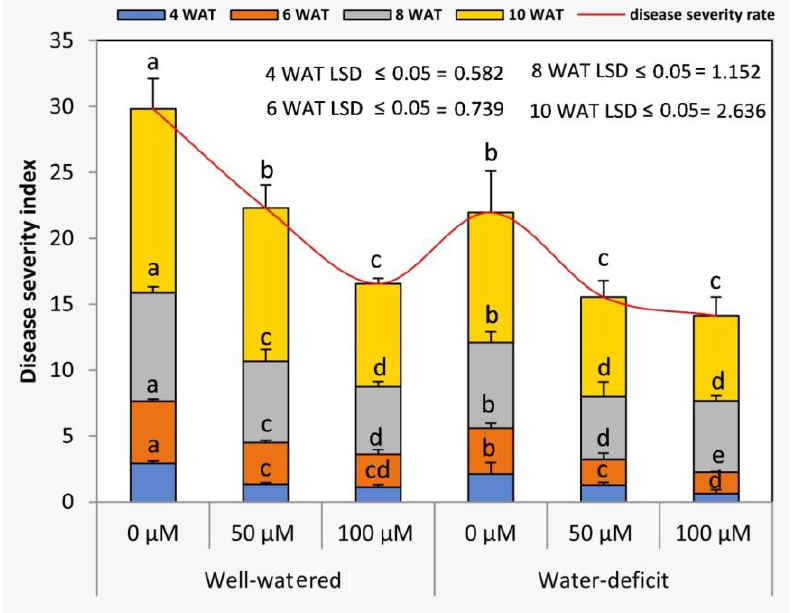
Figure 7. Effects of SNP as foliar applications at 0, 50, and 100 µ M on the viral disease severity index of tomato plants. In each variable, data followed by the same letters are not significantly different using the LSD multiple rang test at a 5% level. WAT: weeks after transplanting.